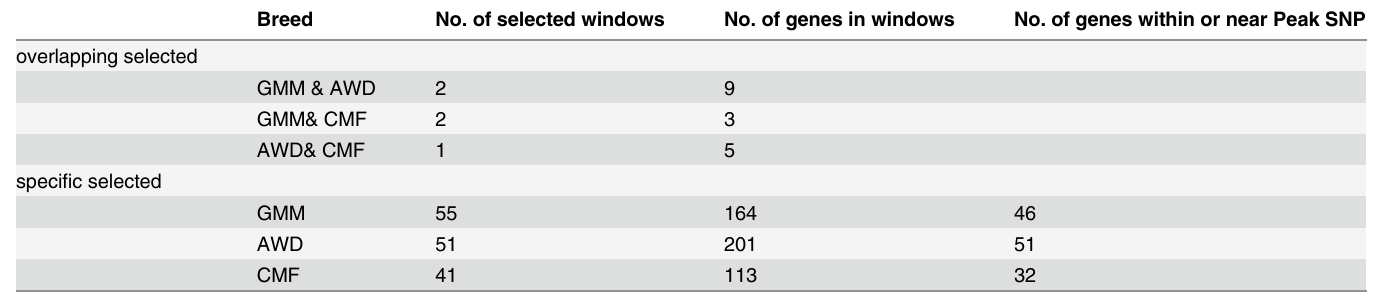
Table 2. The annotation details in specific selected and overlapping selected region. Breed No. of selected windows No. of genes in windows No. of genes within or near Peak SNP overlapping selected GMM & AWD 2